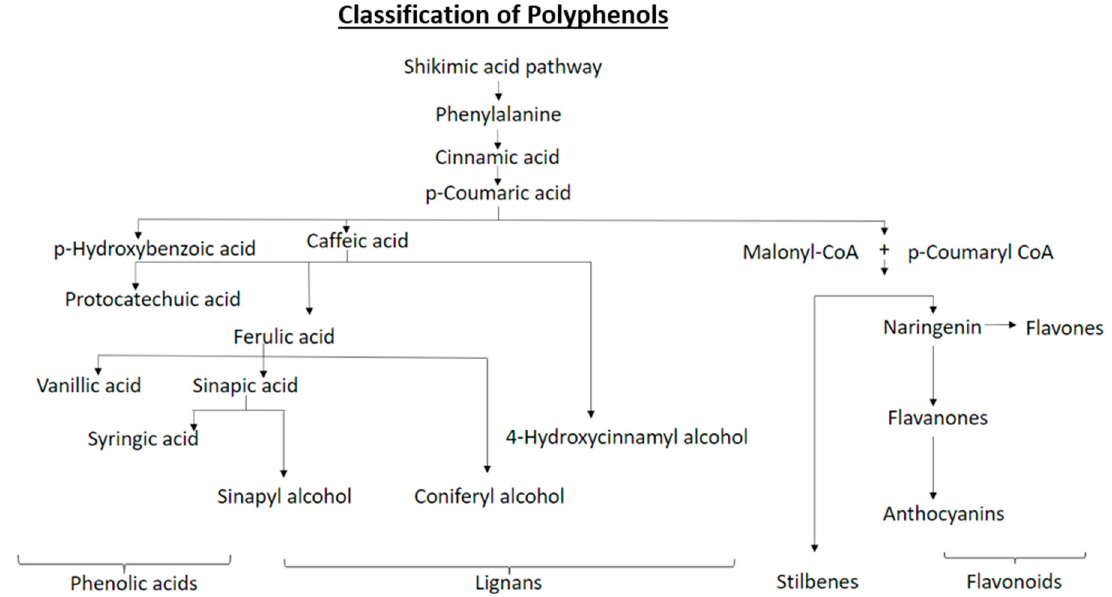
Figure 1. Basic classification and synthesis outline of major polyphenol classes in plants.